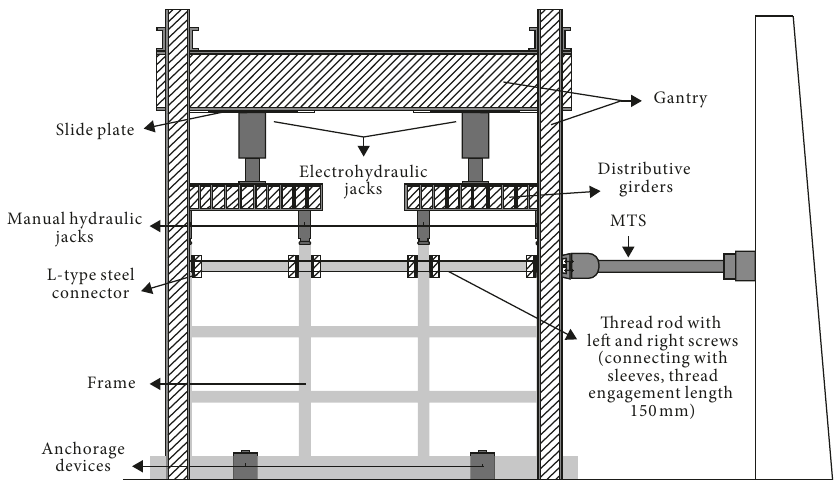
Figure 6: Overview of the test